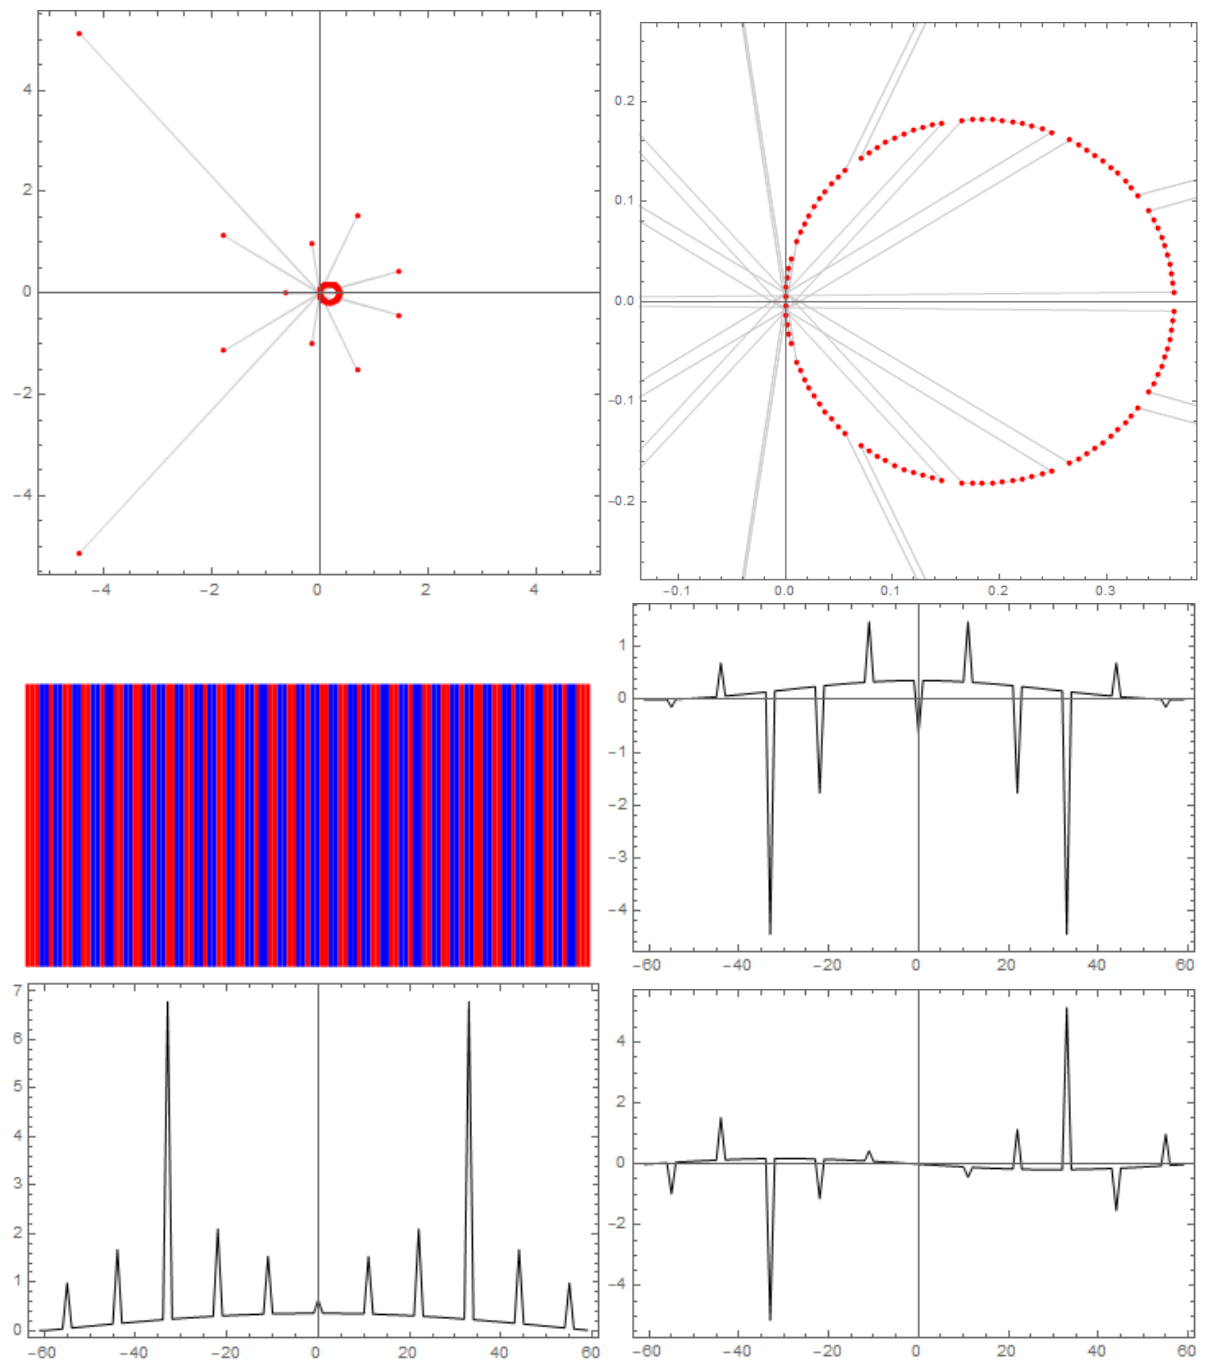
Figure 8. Fourier analysis of the perfect square and nonsquare profiles for the case of m = 11 2 = 121. The top panels show the scatter plot of the discrete Fourier transform of T 121 (full plot, left panel, zoomed in, right panel.) The ordinate is the imaginary value and the abscissa is the real value. The middle left panel shows the block-color plot of the perfect squares (red) and nonsquares (blue) in T 121 . The bottom left panel shows the absolute value of the discrete Fourier transform. The middle right and bottom right panels show the real and imaginary parts of the discrete Fourier transform, respectively. Fourier transforms were performed using M ATHEMATICA